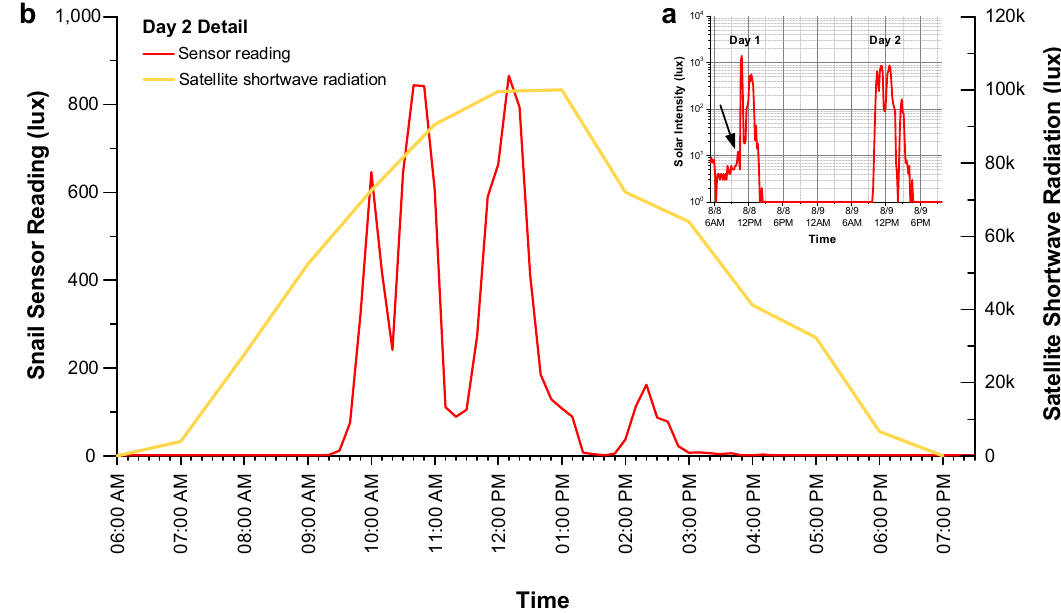
Fig. 2 Solar ecology readings for a single Fautaua-Iti specimen of Euglandina rosea over two days. a The predator ’ s light intensity pro fi le is shown for August 8th (Day 1), 2017 and, after it eluded recapture, for August 9th (Day 2), 2017. The black arrow indicates when E. rosea was released after the sensor attachment. b A detailed view of the predator ’ s August 9 light intensity pro fi le superimposed with that day ’ s record of Tahitian solar irradiation levels, measured by satellite and obtained from meteoblue 49